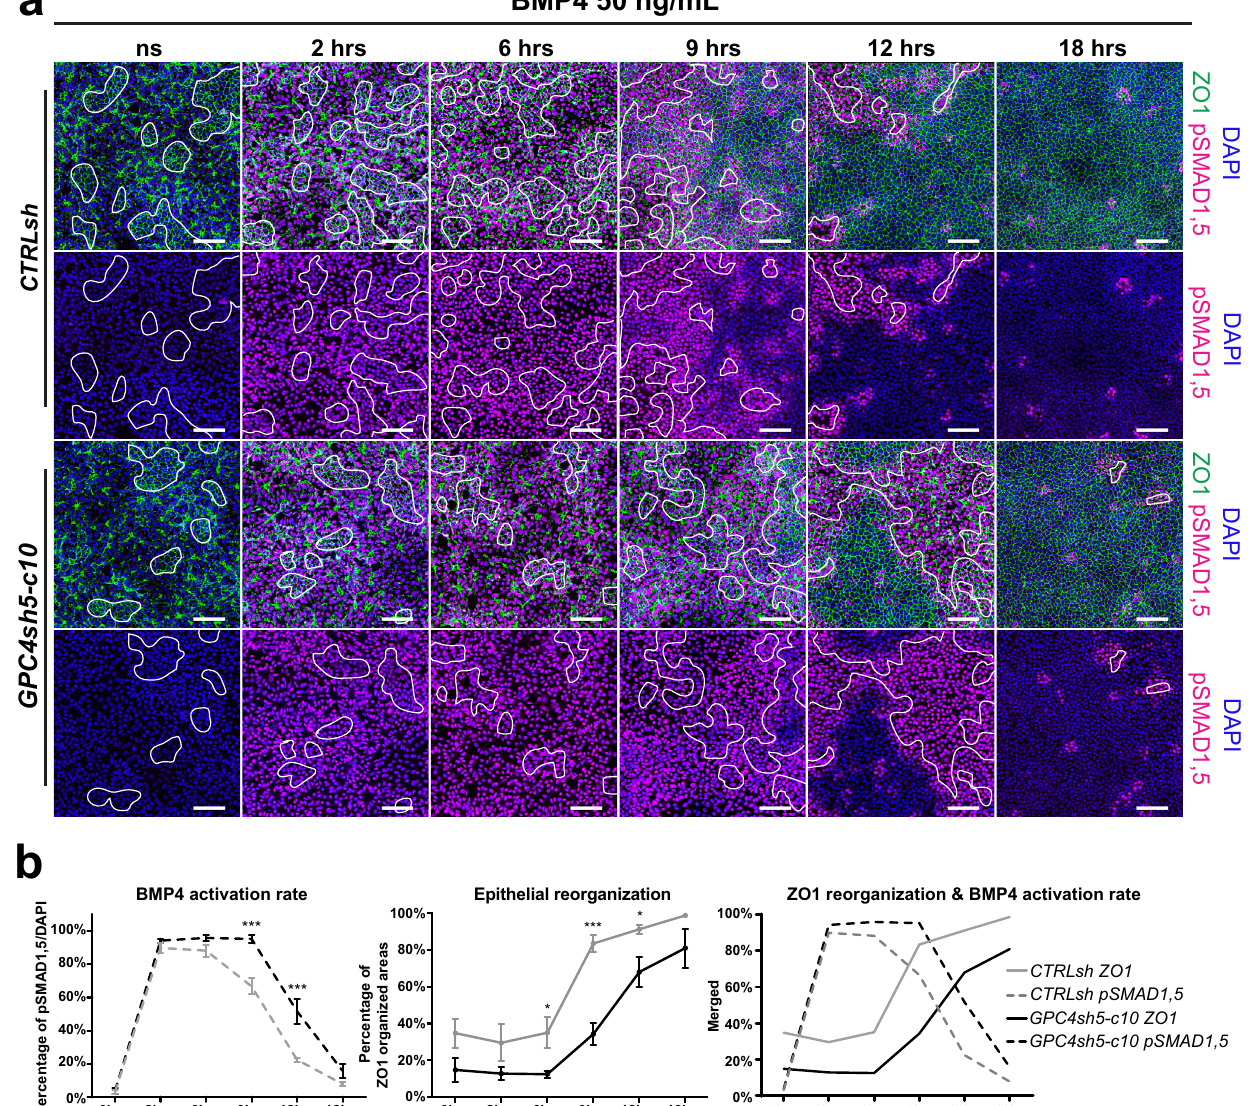
Fig. 8 | GPC4 modulates hiPSC epithelial layer organization by impacting on thekineticsofTJformation.a TimecourseanalysisofTJformationinCTRLshand GPC4shhiPSCs after celldissociationand seeding in combination with the analysis of pSMAD1,5 expression in response to BMP4 stimulation for 2, 6, 9, 12 and 18h. Cells were subjected to immuno fl uorescence analysis of pSMAD1,5 (magenta) and ZO1 (green) proteins, n =3. Scale bar: 100 μ m. b Quantitative analysis from the staining shown in a of pSMAD1,5 positive cells (left panel) and of ZO1 organized areas (middle panel) in CTRLsh and in shGPC4 hiPSC cultures. Note the different kineticsin GPC4sh cultures versus controls. The right panel showthe combination